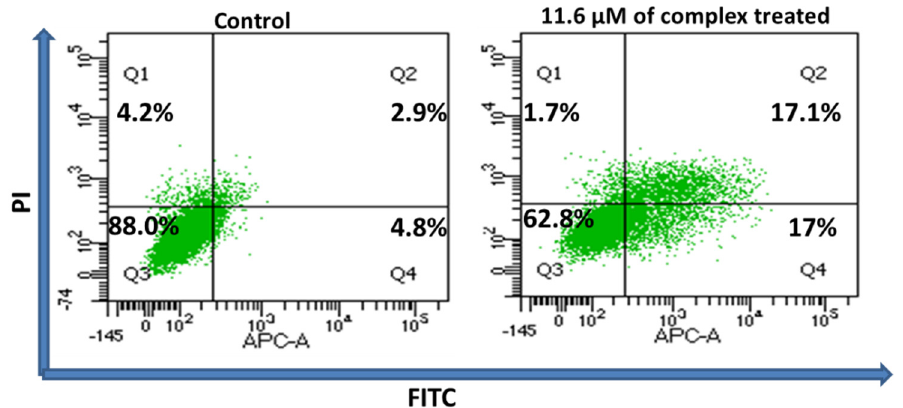
Figure 8. Annexin-V/PI staining data after 24 h of 11.6 µ g/mL complex 1 treatment to analyse the percentage of cell death (apoptosis/necrosis) in HCT 116 cells. Where Q3, Q4, Q2, and Q1 indicate viable cells, early apoptosis, late apoptosis, and necrosis, respectively.